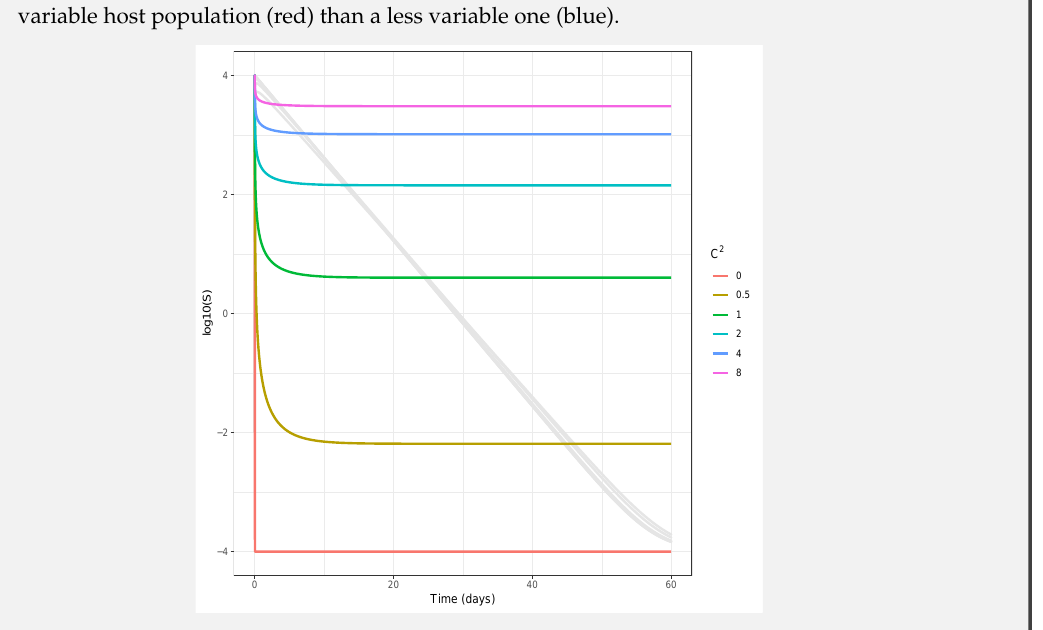
Figure 3. Numerical simulation of a single epidemic of the one strain heterogeneity model (Model 2 in Table 1) for different values of heterogeneity of transmission C 2 . Colored lines show the population density of healthy insects and grey lines show the population density of pathogen over a period characteristic of the duration of larval stages of some